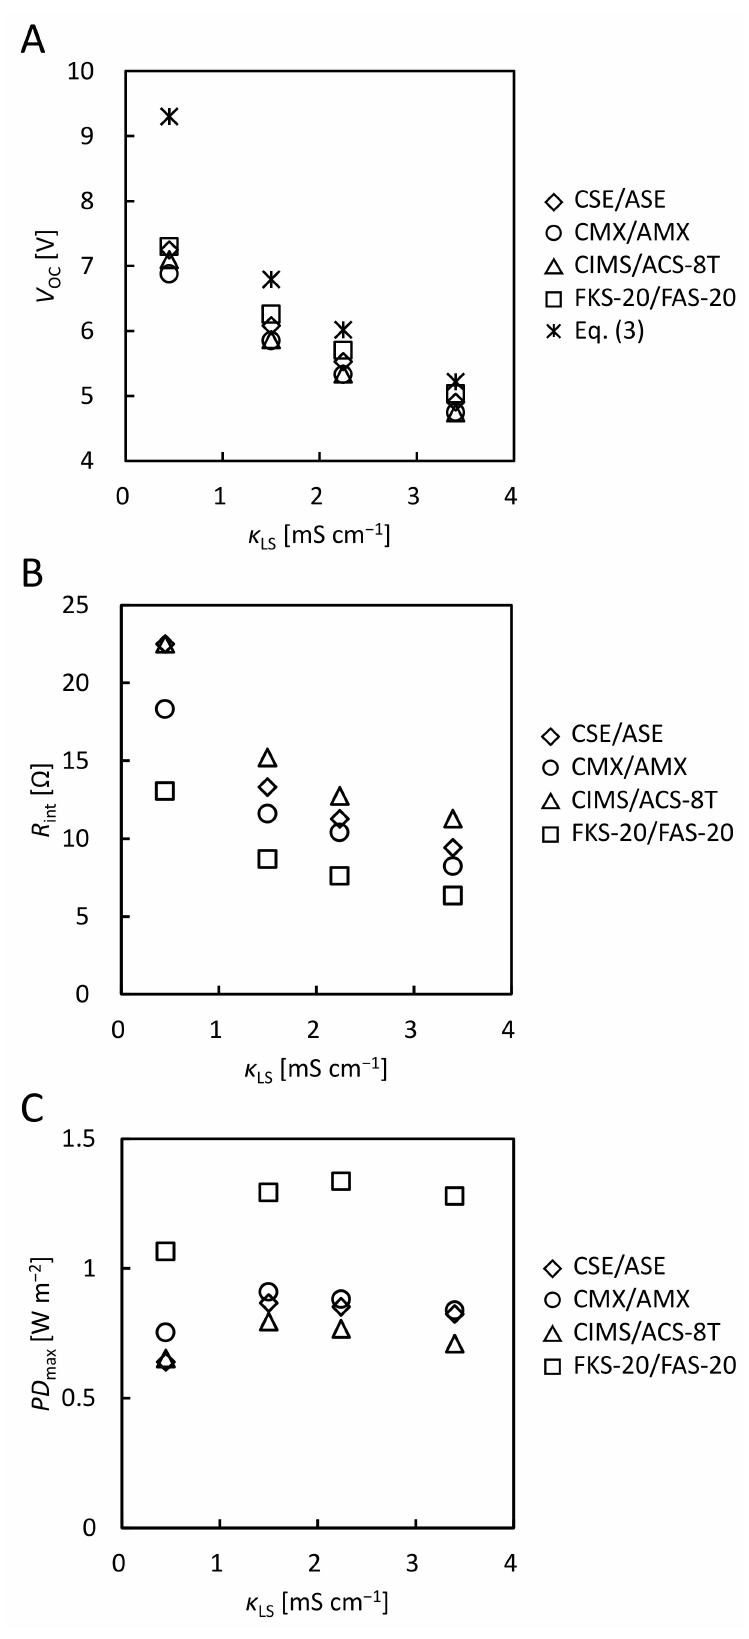
Figure 2. κ LS dependence of (A) V OC , (B) R int , and (C) PD max using model SW (50 mS cm − 1 NaCl) as HS and model RW as